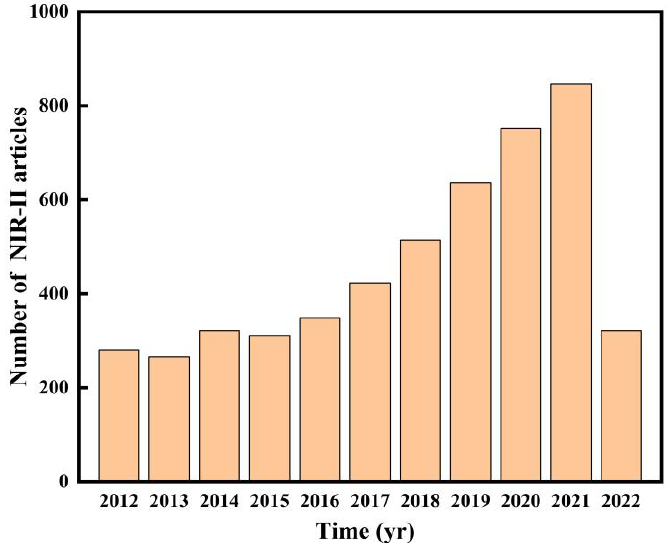
Figure 2. The number of published articles on NIR-II in the past ten years, based on Web of